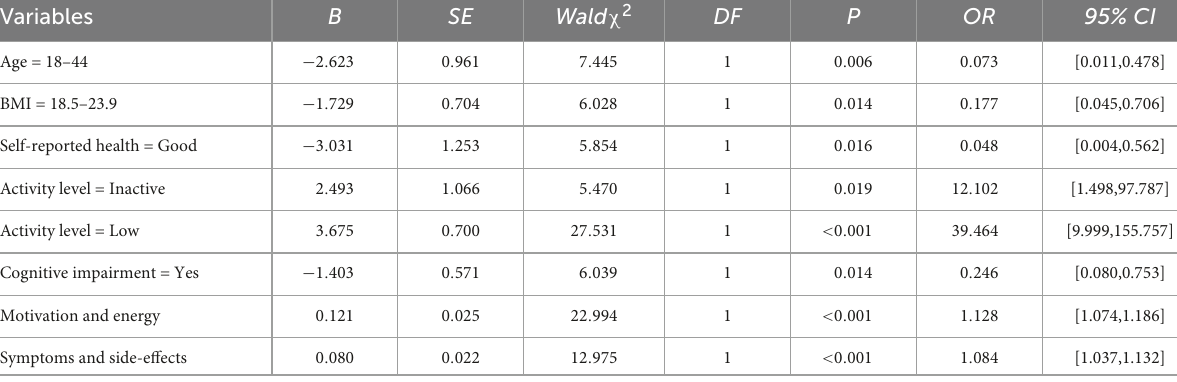
TABLE 4 Logistic regression analysis of factors related to frailty.